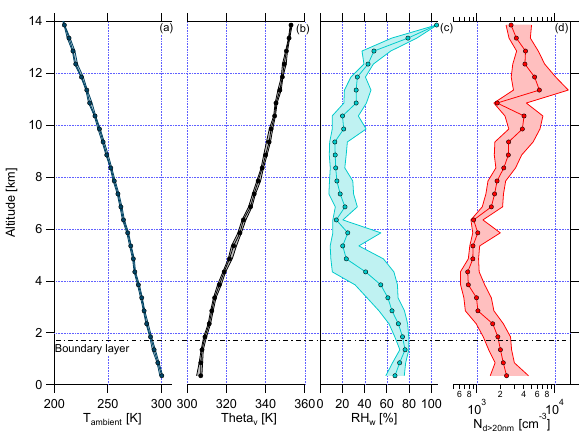
Figure 2. Vertical profiles of (a) ambient temperature ( T ambient ), (b) virtual potential temperature ( (cid:50) v ), (c) relative humidity with respect to water (RH w ), and (d) aerosol number concentration for particle diameters larger than 20nm ( N d > 20nm ) for all flights dur- ing the ACRIDICON-CHUVA campaign. Here medians (connected dots) with interquartile ranges (shaded area) are shown for each plot. The horizontal dashed line shows the mean height of the top of the boundary